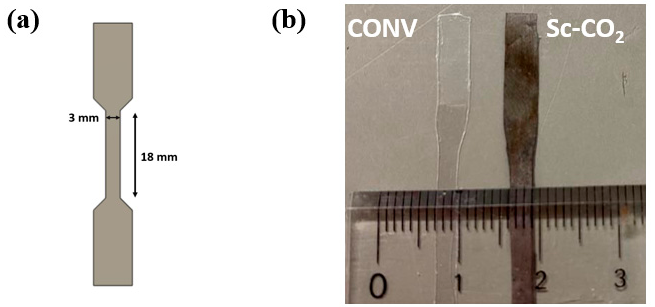
Figure 1. ( a ) Illustration of the dog ‐ bone ‐ shaped specimen. ( b ) Appearances of comparison of met ‐ alized PET catalyzed in conventional solution and sc ‐ CO 2